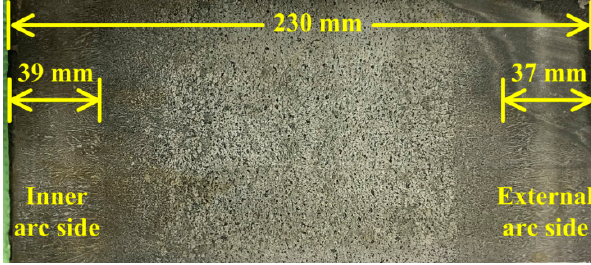
Figure 2. Etched macrostructure of slab.